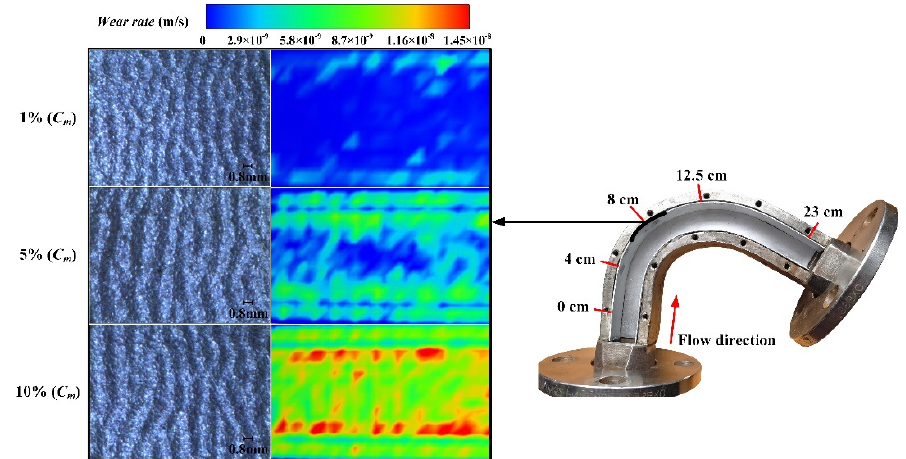
Figure 6. Wear topography (experiment), wear cloud picture (simulation) in the flow field (simulation) at 8 cm for mass concentrations of 1%, 5%, and 10%.